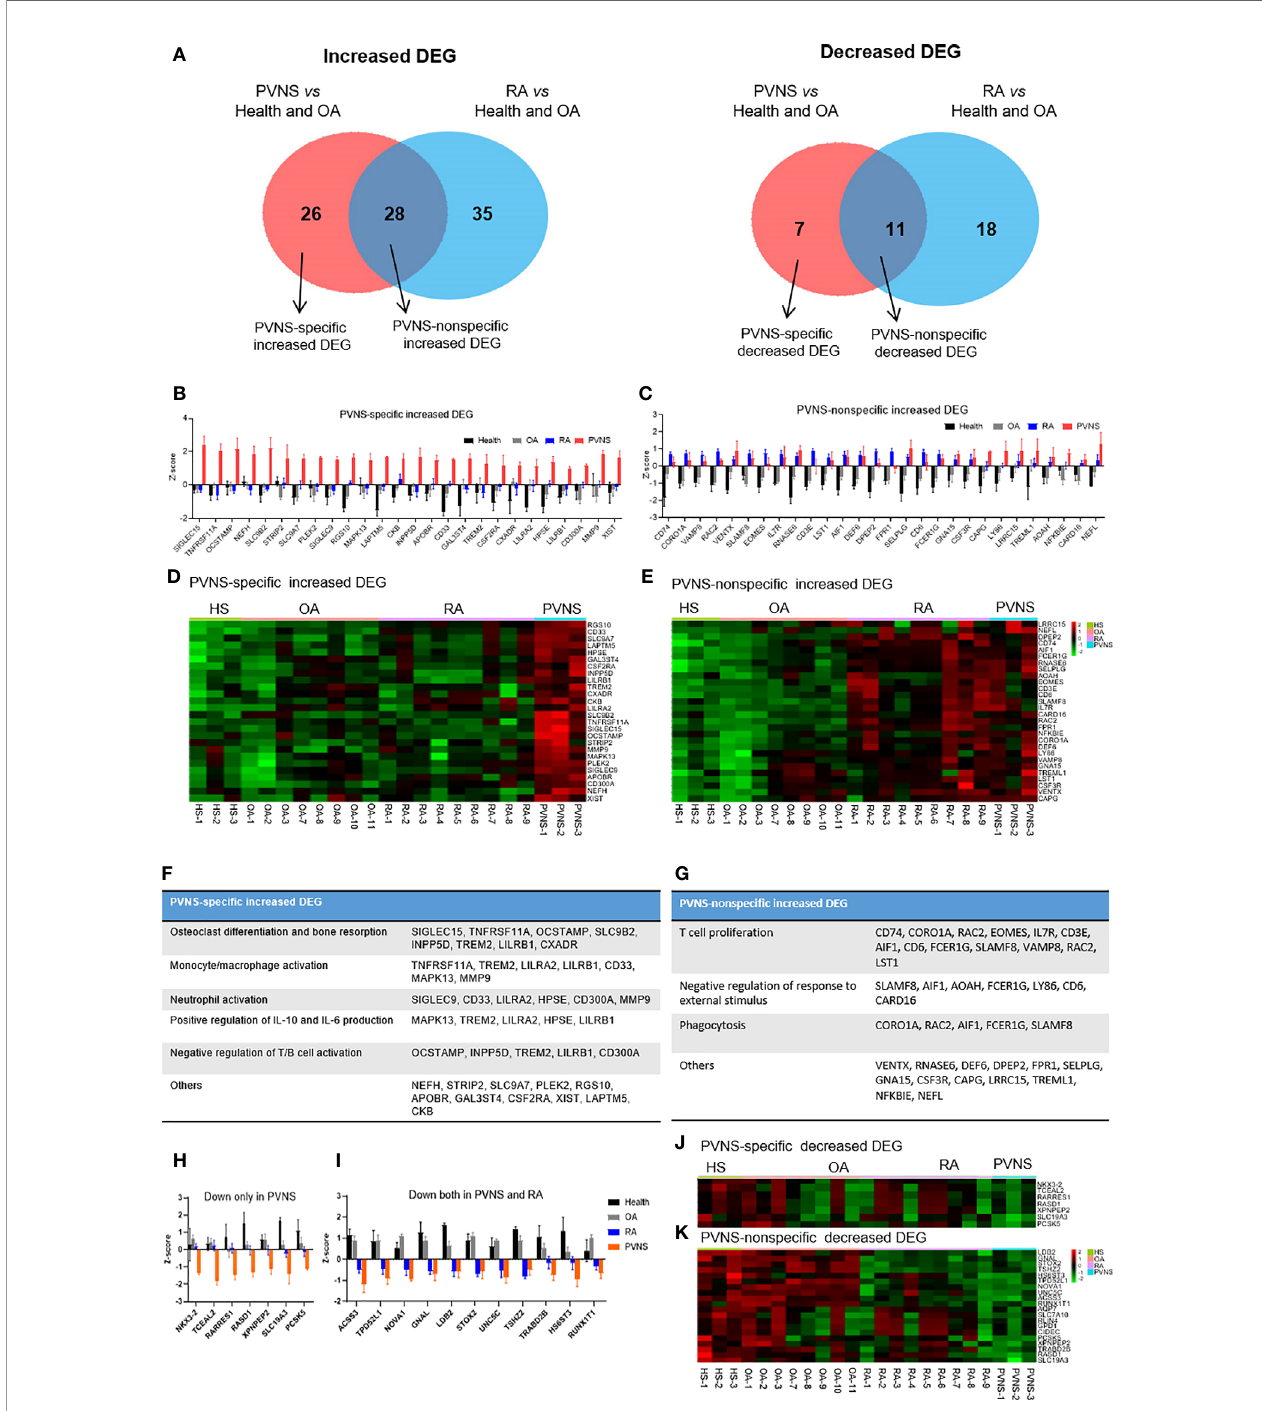
FIGURE 6 | PVNS-speci fi c DEG. analysis compared with rheumatoid arthritis (RA). (A) Venn diagram of increasing (left) and decreasing (right) DEGs of PVNS vs . OA and PVNS vs . Health (GSE143514). Only genes with q-value< 0.01, fold change > 2, and fragments per kilobase of transcript per million mapped reads > 1 were included. DEG only in PVNS were described as “ PVNS-speci fi c DEG ” , and DEG shared by PVNS and RA were described as “ PVNS-nonspeci fi c DEG. ” (B, C) Individual increasing DEG mRNA expression in healthy subjects (n=3), OA patients (n=8), RA patients (n=9), and PVNS patients (n=3) were calculated and shown by z-score. (D, E) Corresponding heatmap of increasing DEG in each samples. (F, G) Functional enrichment analysis for “ PVNS-speci fi c increasing DEG ” and “ PVNS- nonspeci fi c increasing DEG ” . (H, I) Individual decreasing DEG mRNA expression in healthy subjects (n=4), OA patients (n=8), RA patients (n=9), and PVNS patients (n=3) were calculated and shown by z-score. (J, K) Corresponding heatmap of decreasing DEG in each